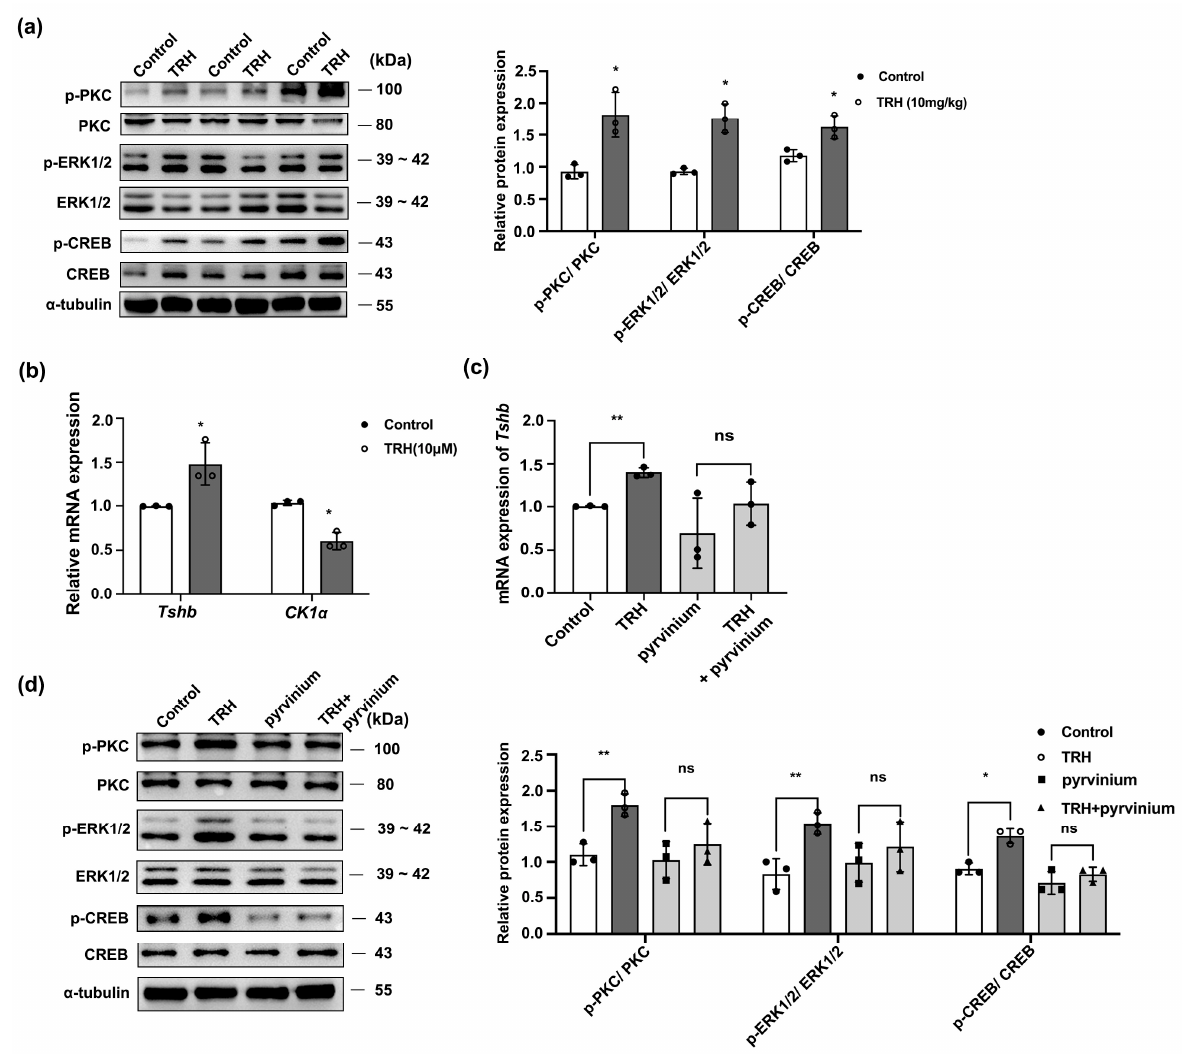
Figure 5. CK1 α mediates the TRH-protein kinase C-extracellular signal-regulated kinase-cAMP re- sponse element binding (TRH-PKC-ERK-CREB) signaling pathway and TSH synthesis. ( a ) After in- jecting TRH (10 mg/kg) into mice, p-PKC, p-ERK1/2, p-CREB, PKC, ERK1/2, and CREB levels were assessed using Western blo tt ing. Relative p-PKC, p-ERK1/2, and p-CREB protein levels were quan- ti fi ed after normalization to those of total PKC, ERK1/2, and CREB, respectively; * p < 0.05, ** p < 0.01 and ns = no signi fi cant, n = 3. ( b , c ) Tshb mRNA and CK1 α mRNA were detected by RT-PCR to de- termine the in vitro treatment time of TR. Primary pituitary cells were then pre-treated with pyrvin- ium for 1 h and then treated with 10 µM TRH for 30 min. Tshb mRNA was assayed using RT-PCR and normalized to Gapdh expression; * p < 0.05, ** p < 0.01 and ns = no signi fi cant, n = 3. ( d ) p-PKC, p-ERK1/2, p-CREB, PKC, ERK1/2, and CREB expression levels were determined using Western blot- ting. Expression levels were checked and measured by gray value assessment and normalized to total PKC, ERK1/2, and CREB as the internal reference; * p < 0.05, ** p < 0.01 and ns = no signi fi cant, n = 3.